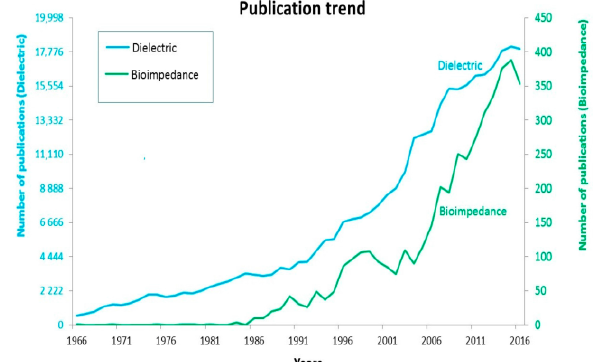
Fig.1: Number of publications on bioimpedance during the last 30 years in comparison with the growth of dielectric impedance papers (extracted from the Scopus based analysis given in [1], published under CC BY 4.0).